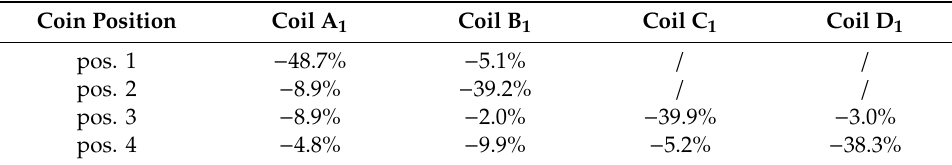
Table 2. γ with the coin at di ff erent positions (pos.).